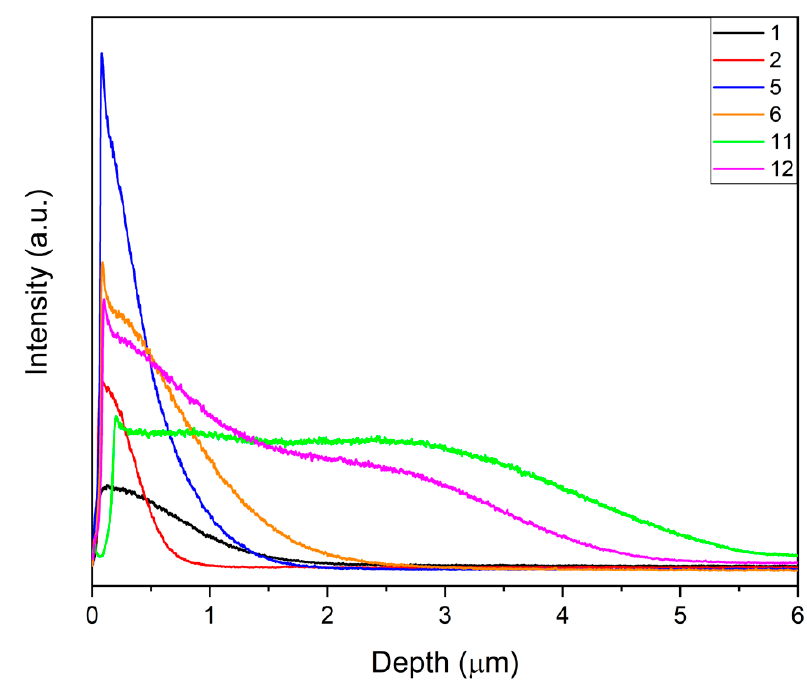
Figure 11. Comparison of Nb GDOES profiles of different samples.